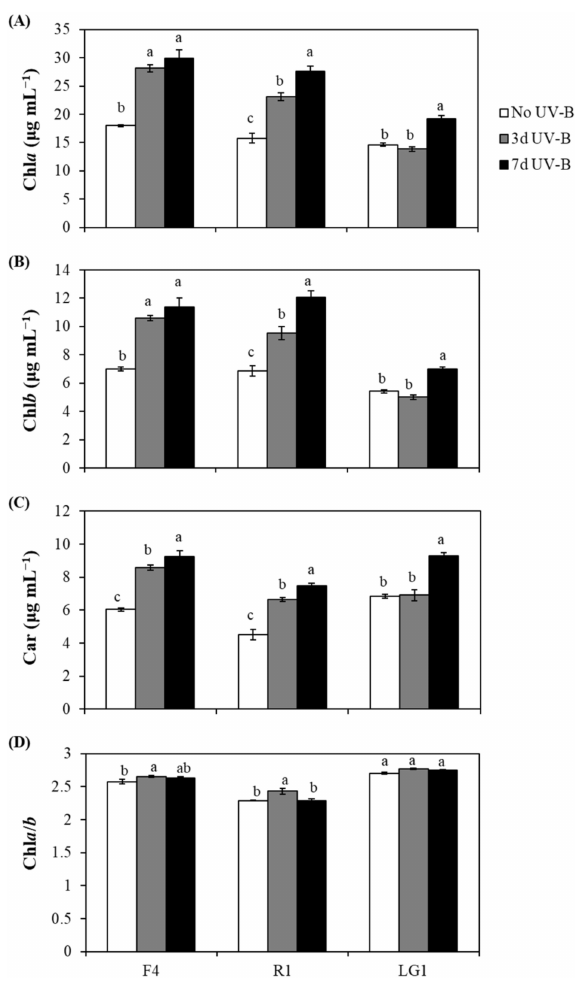
Figure 1. Effect of UV-B on photosynthetic pigments in microalgae subjected to cigarette butt (CB)- derived wastewater treatment. ( A ) Chlorophyll a (Chl a ), ( B ) chlorophyll b (Chl b ), ( C ) carotenoids (Car) and ( D ) the ratio of Chl a to Chl b (Chl a / b ) were determined in each microalgal strain (F4, R1 and LG1) in 7-day cultures. Microalgae were exposed to wastewater and sequential (3 d UV-B) or parallel (7 d UV-B) UV-B treatments. The UV-B exposure level was set at 1.7 W m − 2 and supplemented with 70 µ mol m − 1 s − 1 photosynthetically active radiation (PAR) for 20 min each day. The control microalgal group only received PAR (No UV-B). For more details, see Section 4. Different letters represent significant differences ( p < 0.05) between UV-B treatments within the same strain. Data are expressed as means of 4 different replicates ± standard error